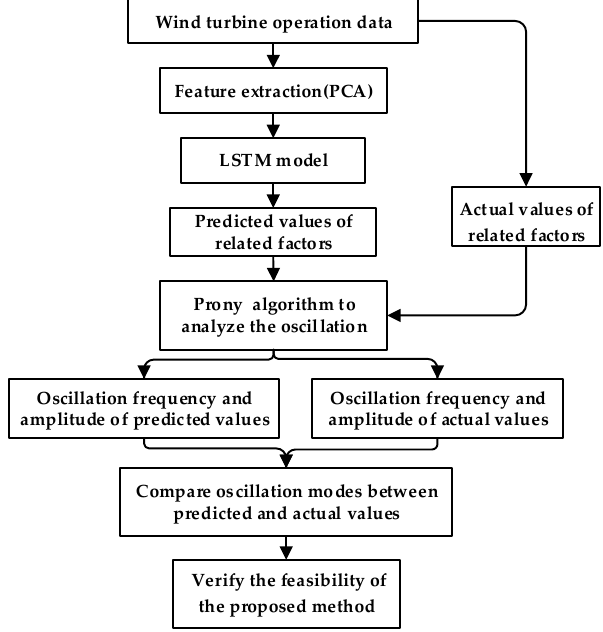
Figure 1. Flowchart of the methodology.